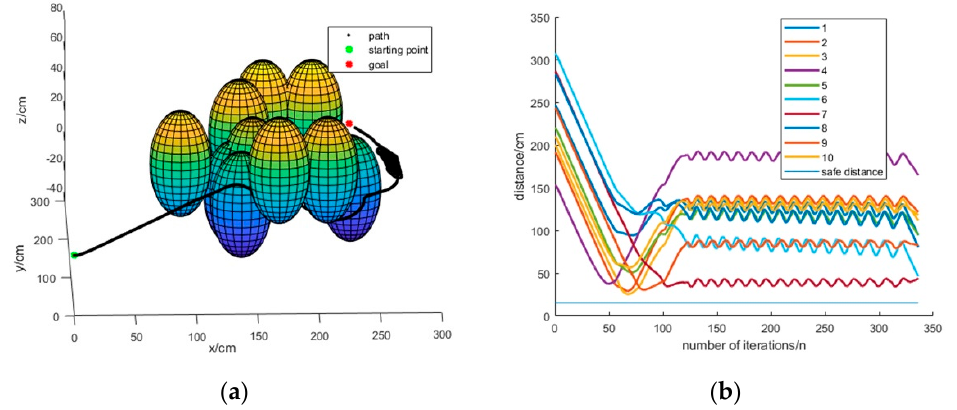
Figure 15. Case with time step in group 2. ( a ) Path planning of 3D map. ( b ) The distance from ob- stacles.